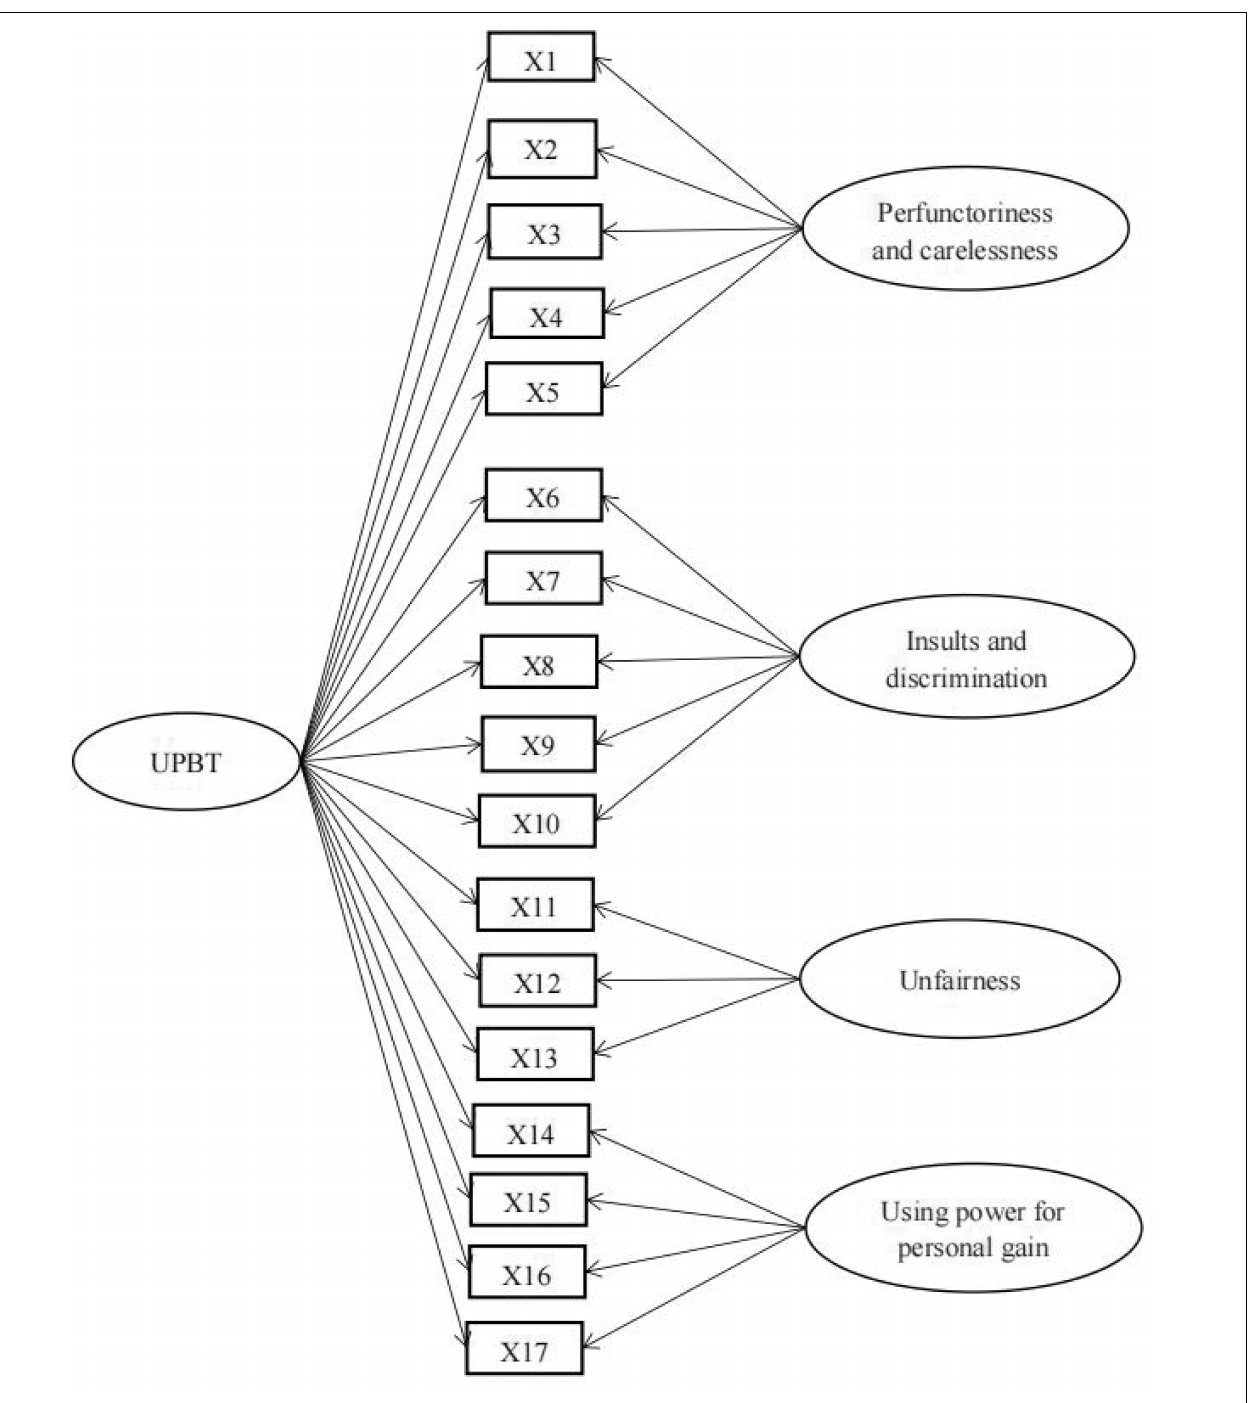
FIGURE 1 | Hypothetical bi-factor model. UPBT = unethical professional behavior tendencies, 17 items were proposed in the procedure section and the item details were presented in Table 1